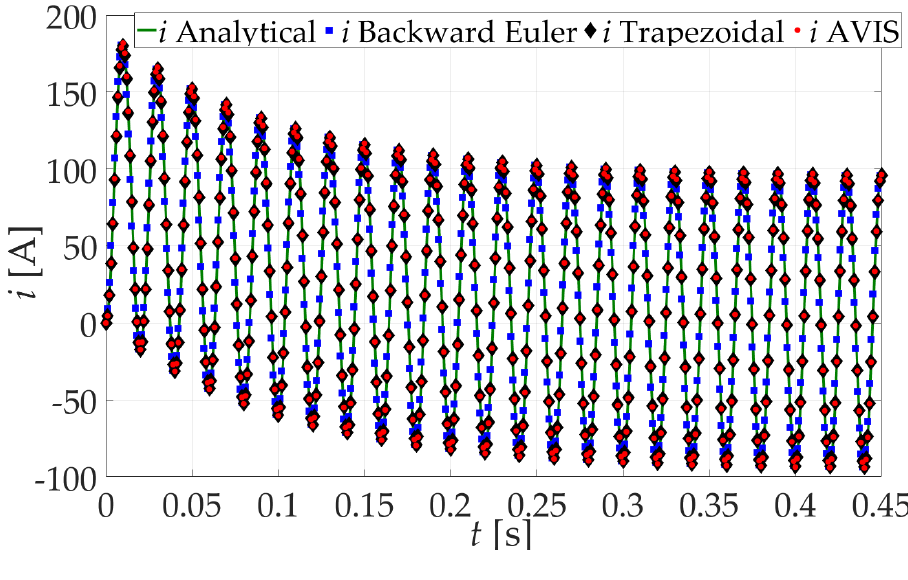
Figure 5. Current waveform caused by connecting the RL clamp to the voltage source with a frequency of 50 Hz.